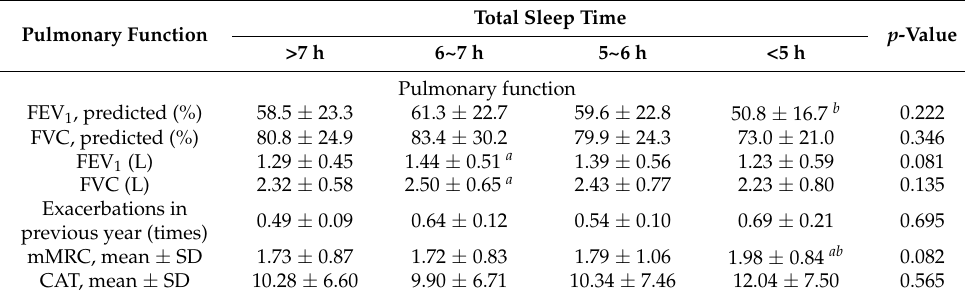
Table 2. Pulmonary function from four groups according to total sleep time.